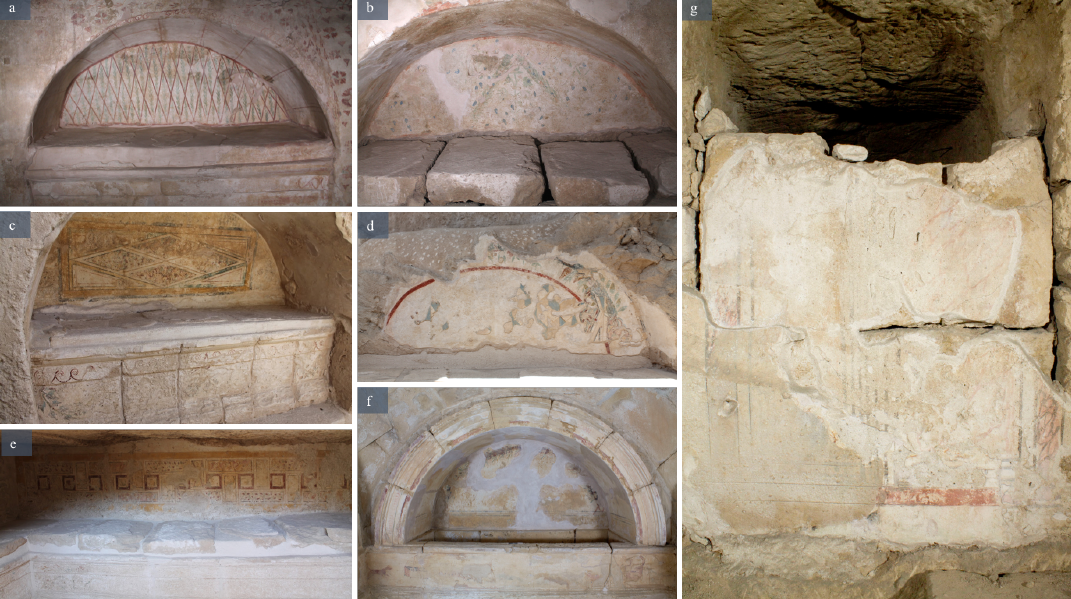
Figure 7. Examples of tombs and their funerary paintings, found in the western and eastern necropoleis, as well as modern-day upper Paphos: ( a , b ) Tomb Silver House 1; ( c – e ) Tomb 3882; ( f ) Tomb Roma 1; ( g ) Tomb Roma